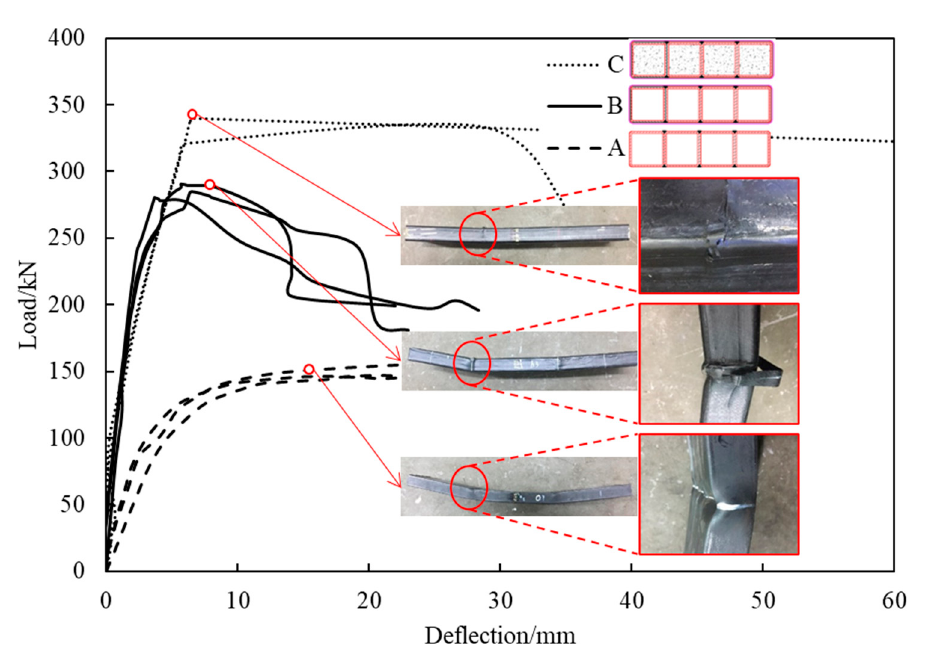
Figure 6. Load–displacement curves of the bending tests.